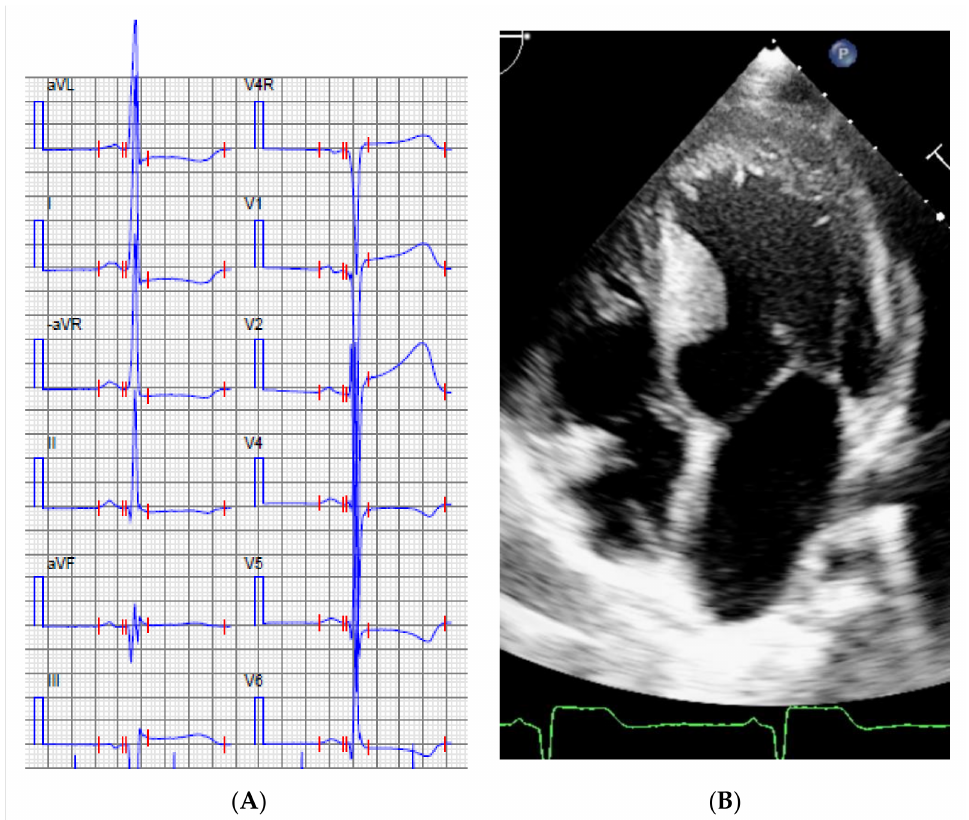
Figure 3. Index patient, Family 1, ECG ( A ) and the echocardiogram, apical 4-chamber view ( B ) at the age of 12